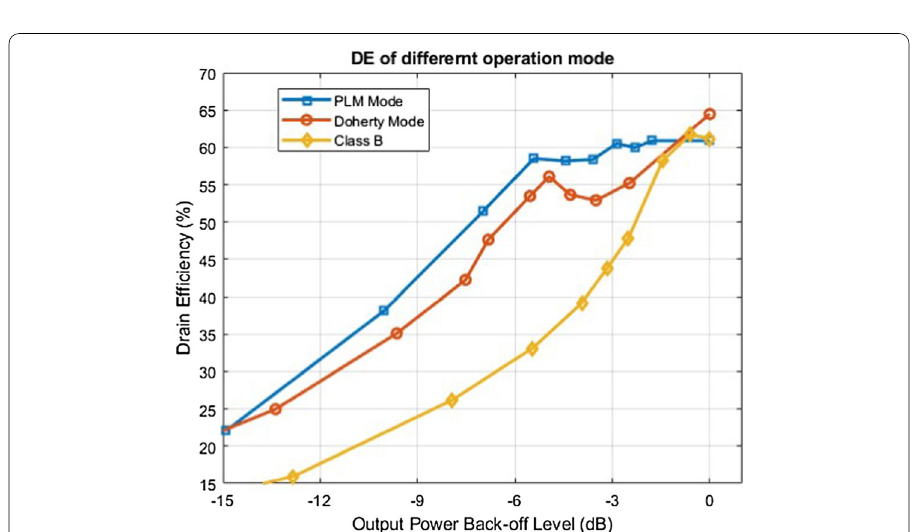
Fig. 16 Measured PA power efficiency with two combined units. The drain efficiency of the PLM mode is obtained with duty cycle test, while the efficiency the Class-B PA and the Doherty PA is measured by controlling the input